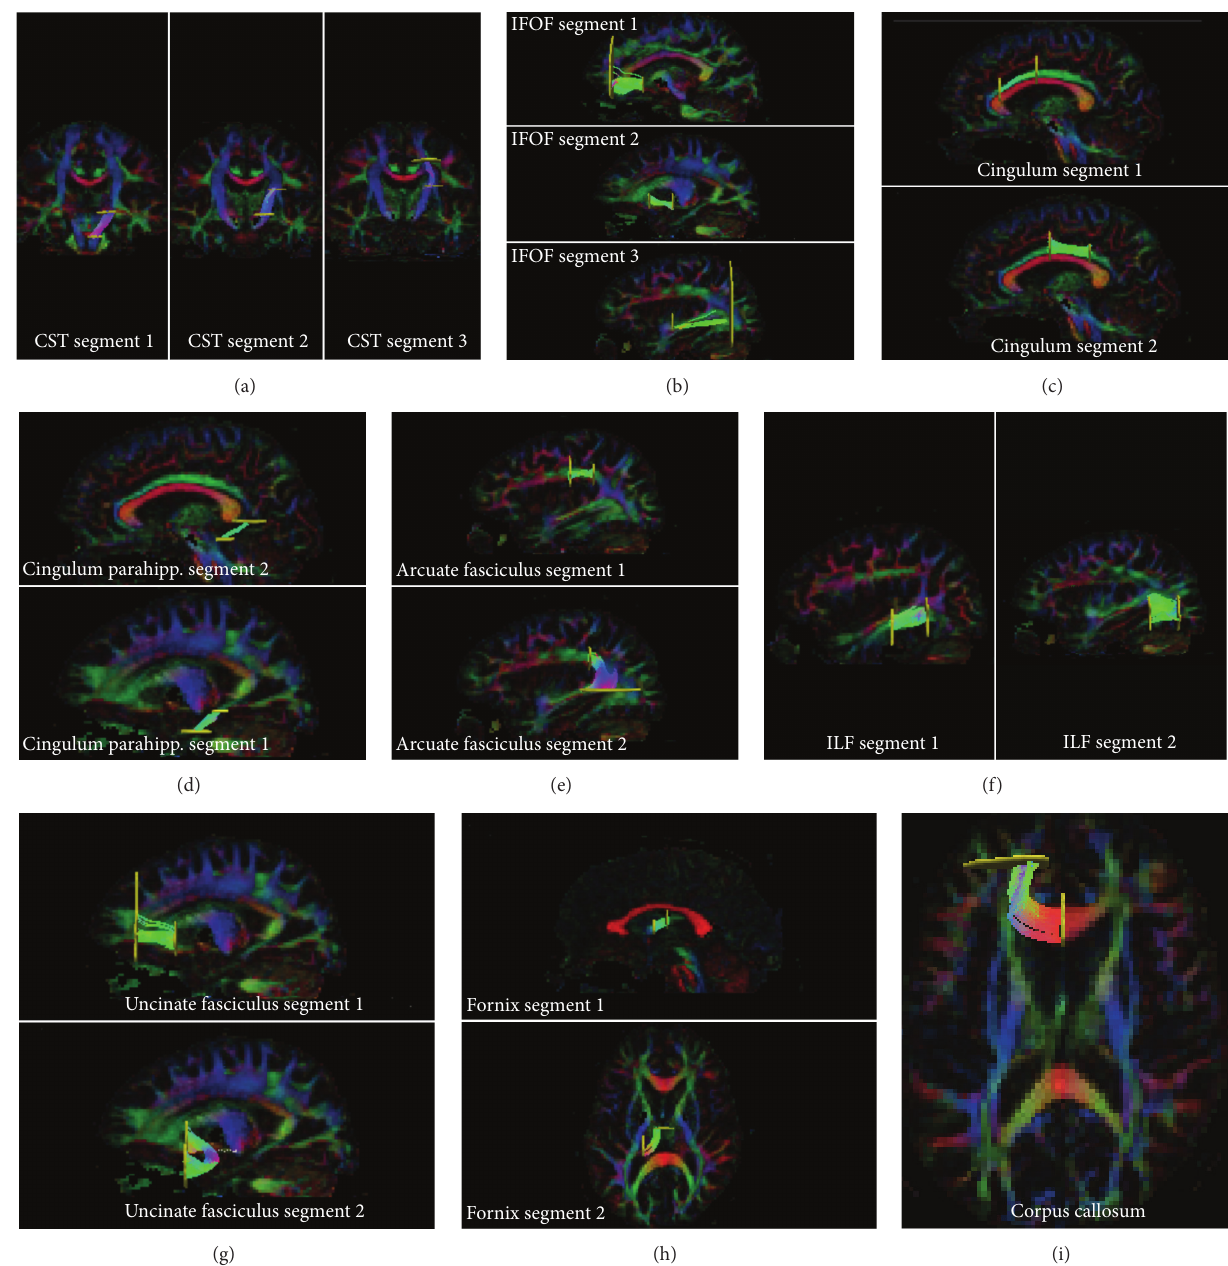
Figure 1: 3D-tractography in TrackVis in all tract segments in one patient, in the hemisphere contralateral to the tumor. (a) Corticospinal tract: segments 1–3. (b) Inferior frontooccipital fasciculus: segments 1–3. (c) Cingulum: segments 1 and 2. (d) Parahippocampal cingulum: segments 1 and 2. (e) Arcuate fasciculus: segments 1 and 2. (f) Inferior longitudinal fasciculus: segments 1 and 2. (g) Uncinate fasciculus: segments 1 and 2. (h) Fornix: segments 1 and 2. (i) Corpus callosum: forceps